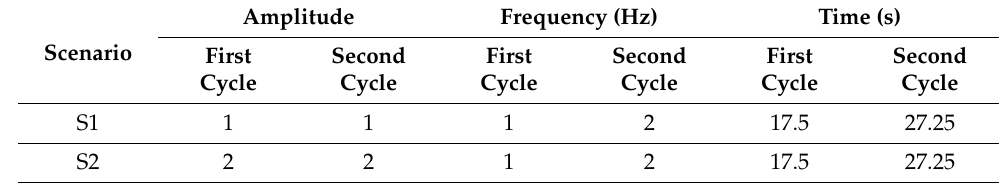
Table 1. Details of the simulated traffic-induced impulsive signals.